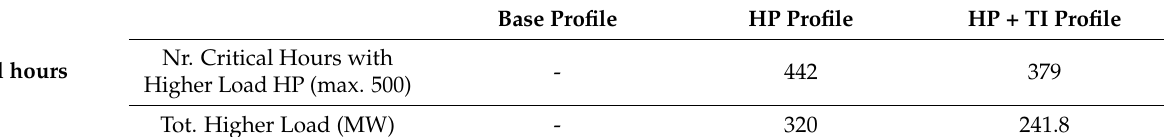
Table 4. Comparison of critical hours to the base case.